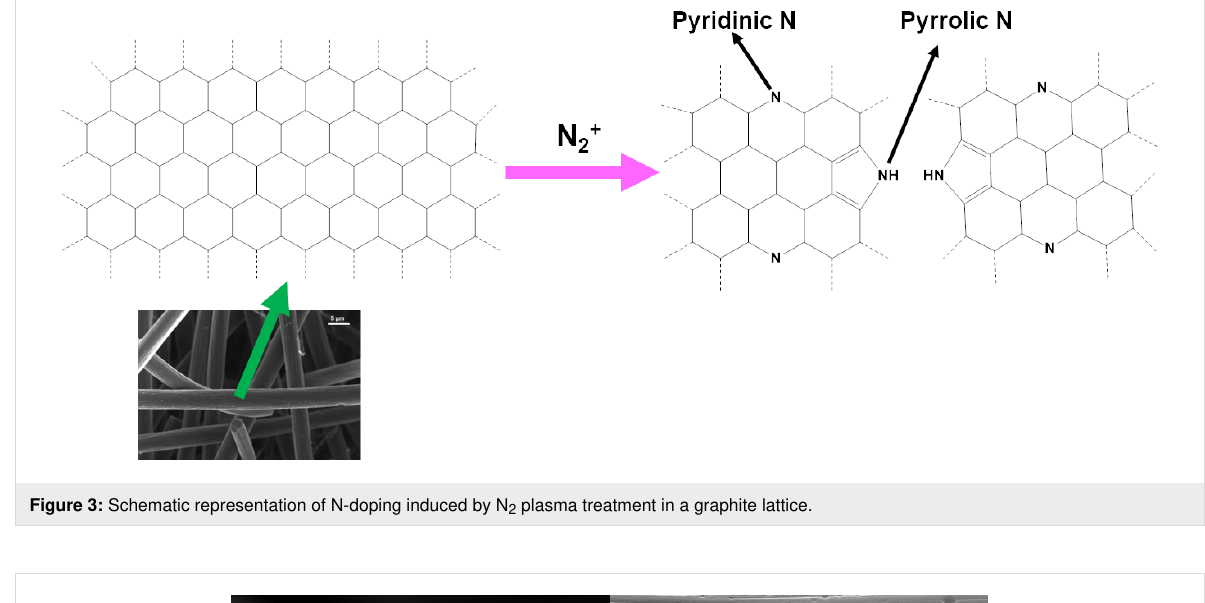
Figure 3: Schematic representation of N-doping induced by N 2 plasma treatment in a graphite lattice.